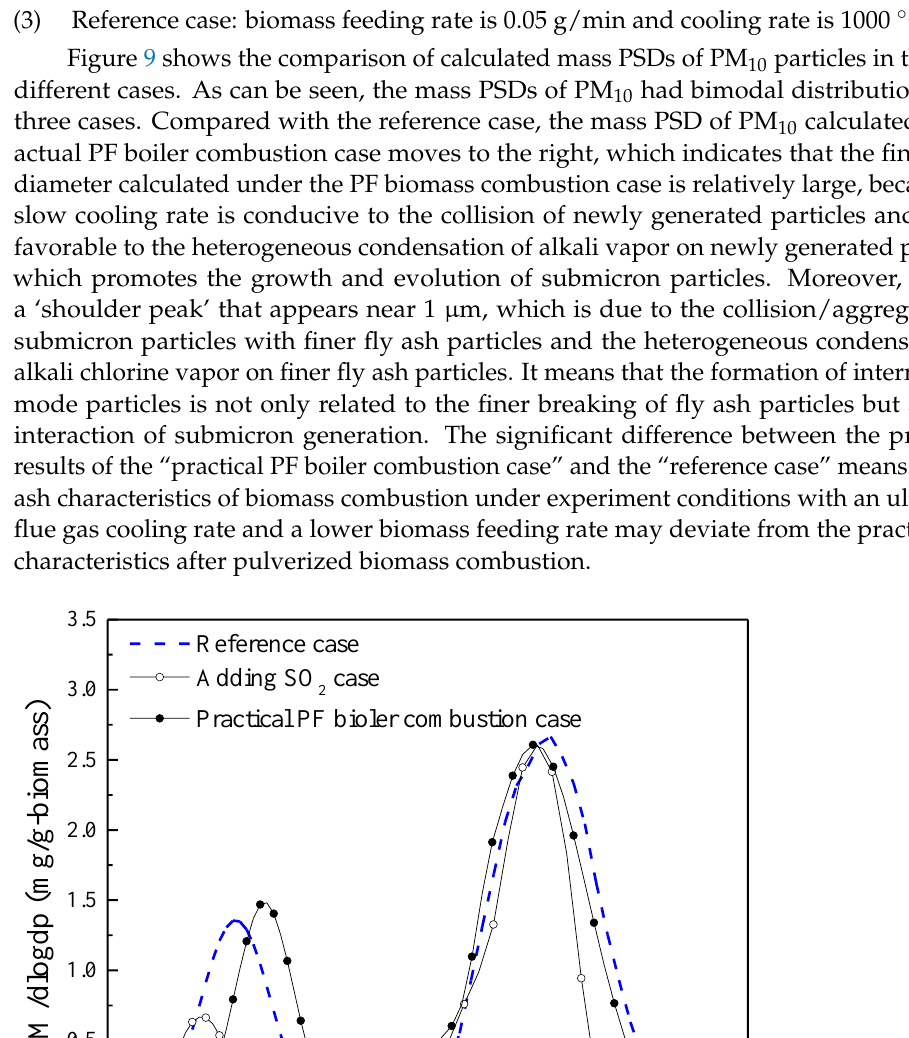
(3) Reference case: biomass feeding rate is 0.05 g/min and cooling rate is 1000 ◦ C/s.